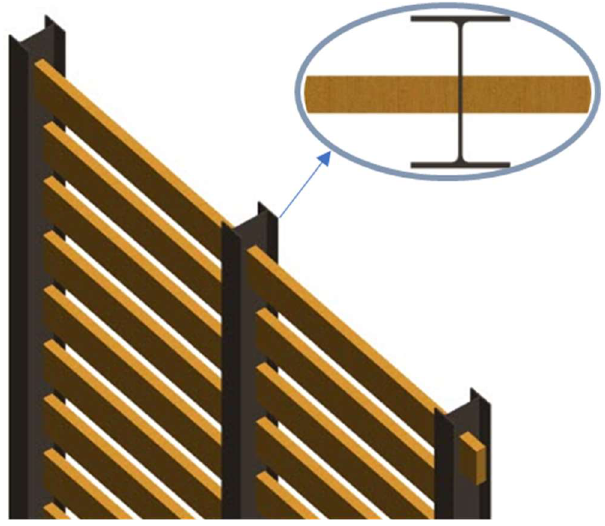
Figure 3. Soldier piles and lagging (H-system).